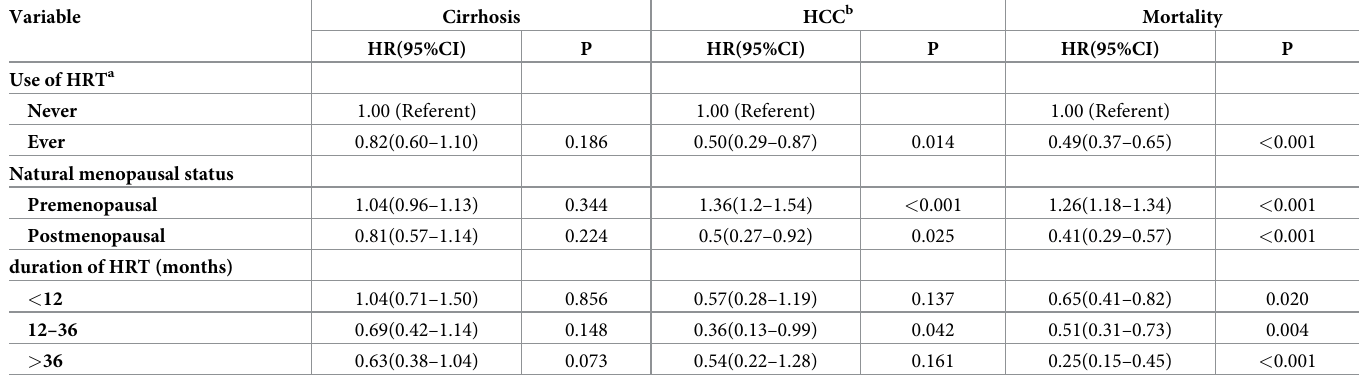
Table 3. Adjusted hazard ratios for the risk of cirrhosis, all-cause mortality, and Hepatocellular Carcinoma (HCC) in the Hormone Replacement Therapy (HRT) cohort after Cox regression analysis.